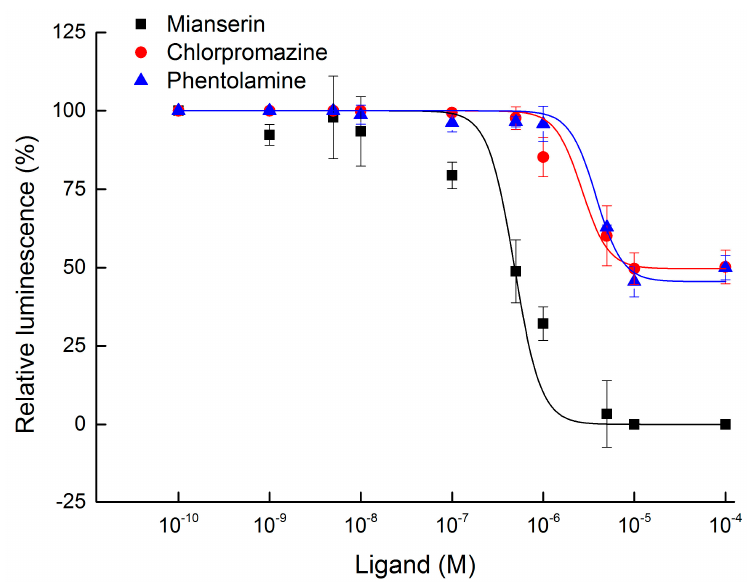
Figure 6. Antagonist concentration-response curves of BdOct β R1. Inhibition of the octopamine-dependent cAMP luminescence was examined on BdOct β R1-expressing HEK-293 cells with mianserin, phentolamine, and chlorpromazine. Each value was normalized to the cAMP luminescence obtained with the positive control, octopamine at 1.00 × 10 − 6 M (=100%). Mean values ± S.E. from three independent tests and three biological replications per experiment.